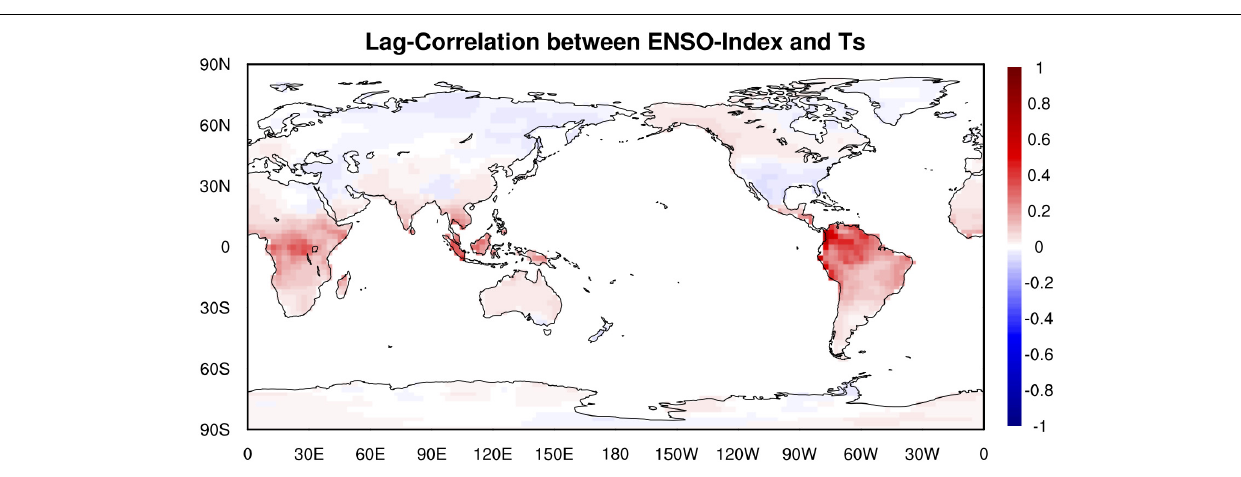
FIGURE 4 | Maximum lag correlation between ENSO index and surface air temperature over